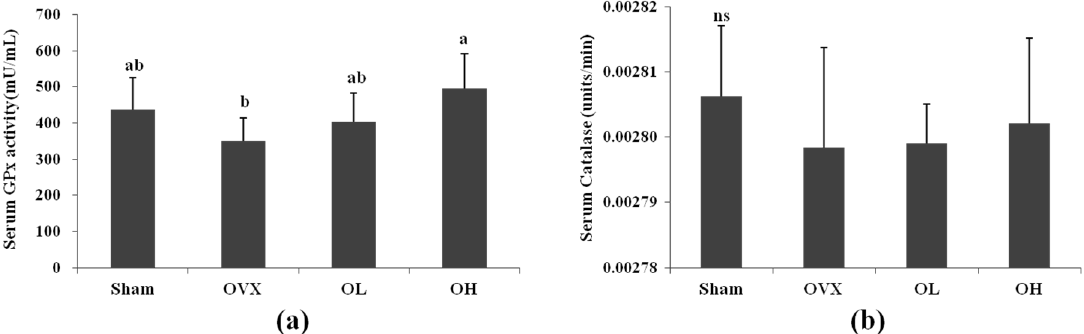
Figure 4. Serum antioxidant enzyme activities of each group. ( a ) Serum GPx; ( b ) Serum catalase. ns, not significant; Values are mean ± SD ( n = 7 for each group). The different letters (a > b > c) within a column indicate significant differences ( p < 0.05) determined by Duncan’s multiple range test; Sham, the non ‐ OVX control; OVX, the OVX ‐ control; OL, the OVX + 100 mg/kg b.w. of hawthorn extract; OH, the OVX + 200 mg/kg b.w. of hawthorn extract; GPx, Glutathione peroxidase.